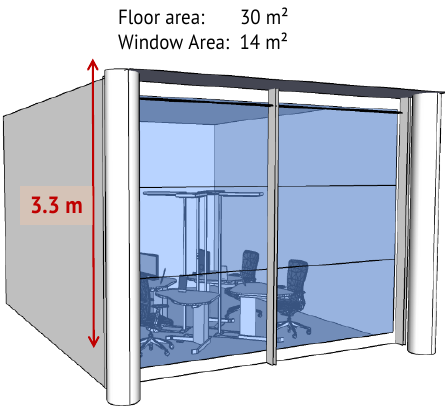
Figure 1. The three different zones of the electrochromic glass fitted to the room.